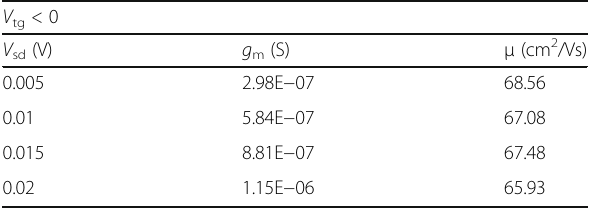
Table 1 The mobility of SnSe 2 FET with top gating measured in the dark